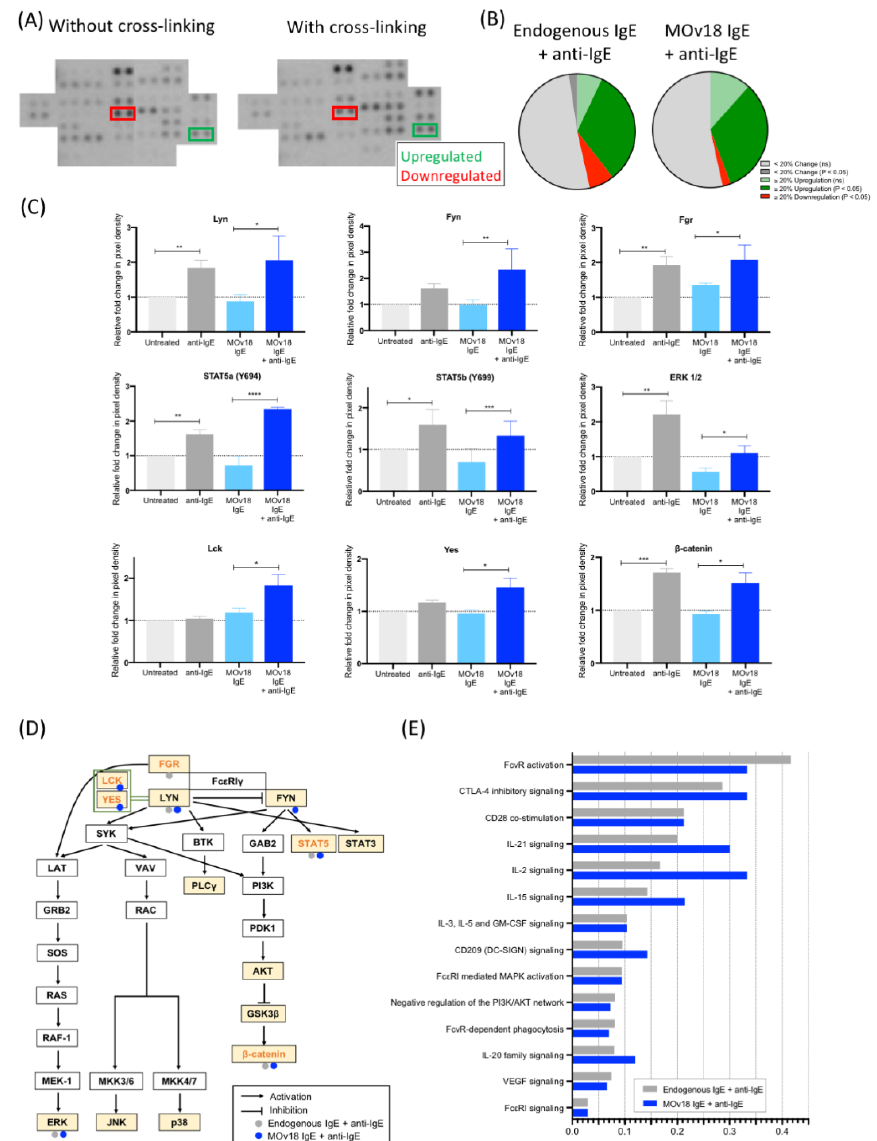
Figure 3. IgE cross-linking on the surface of monocytes activates protein kinases downstream of Fc ε RI α and other immune activatory pathways. ( A ) Images from Proteome Profiler Human Phospho-Kinase ArraywithandwithoutIgEcross-linkingonthesurfaceofhealthyvolunteer-derivedprimarymonocytes. Each kinase is spotted in duplicate. ( B ) Summary of changes in protein kinase phosphorylation after cross-linking endogenous IgE (left) and MOv18 IgE (right). ( C ) Pixel density was analysed and expressed as fold-change relative to “untreated” (light grey) (Y = 1) comparing samples subjected to treatment ( + anti-IgE (dark grey); MOv18 IgE (light blue); MOv18 IgE + anti-IgE (dark blue)). ( D ) Schematic of Fc ε RI pathway network in monocytes generated via the Kyoto Encyclopedia of Genes and Genomes (KEGG) database. Kinases with upregulated phosphorylation upon cross-linking of endogenous IgE (grey) or MOv18 IgE (blue) are indicated. Highlighted in yellow are kinases analysed with the Human Phospho-Kinase Antibody Array. Orange-lettered kinases are newly added onto the pathway based on our observations. ( E ) Other pathways that may be influenced upon IgE cross-linking on the monocyte surface were explored using Reactome pathway enrichment, by studying genes of kinases showing ≥ 20% change in phosphorylation following IgE stimulation. Error bars represent standard error of mean (SEM) ( n = 3 independent experiments). A one-way ANOVA with Tukey’s post-hoc test was performed to assess significance (* p < 0.05; ** p < 0.01; *** p < 0.001; **** p <